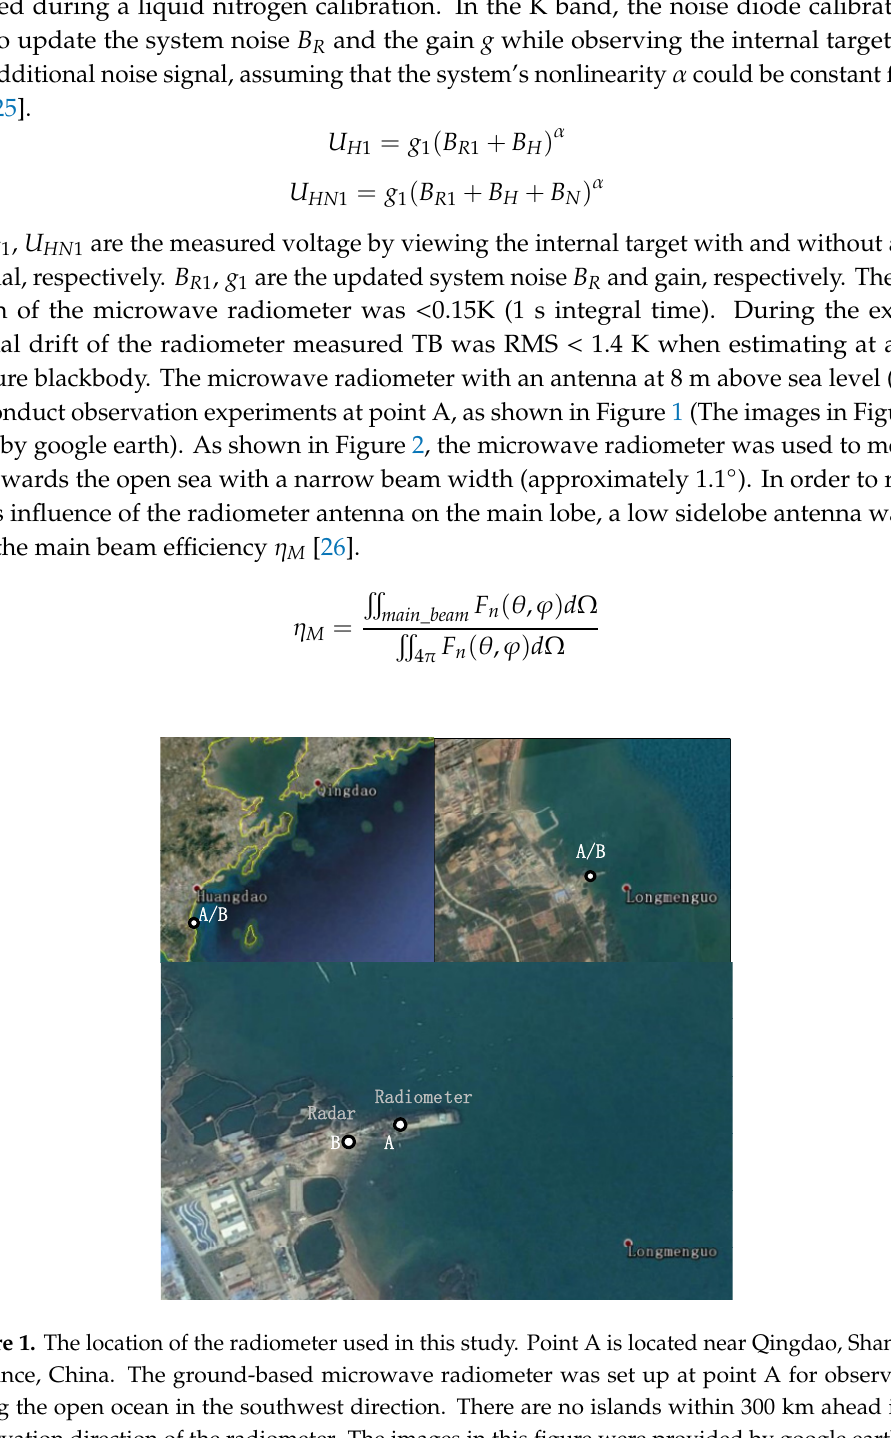
Figure 2. View of the X-band H-polarized microwave radiometer. The microwave radiometer with an antenna 8 meters above sea level was mounted on a truck, and the automatic weather station about 30 m away from the microwave radiometer was fixed at 6 m above the sea level.